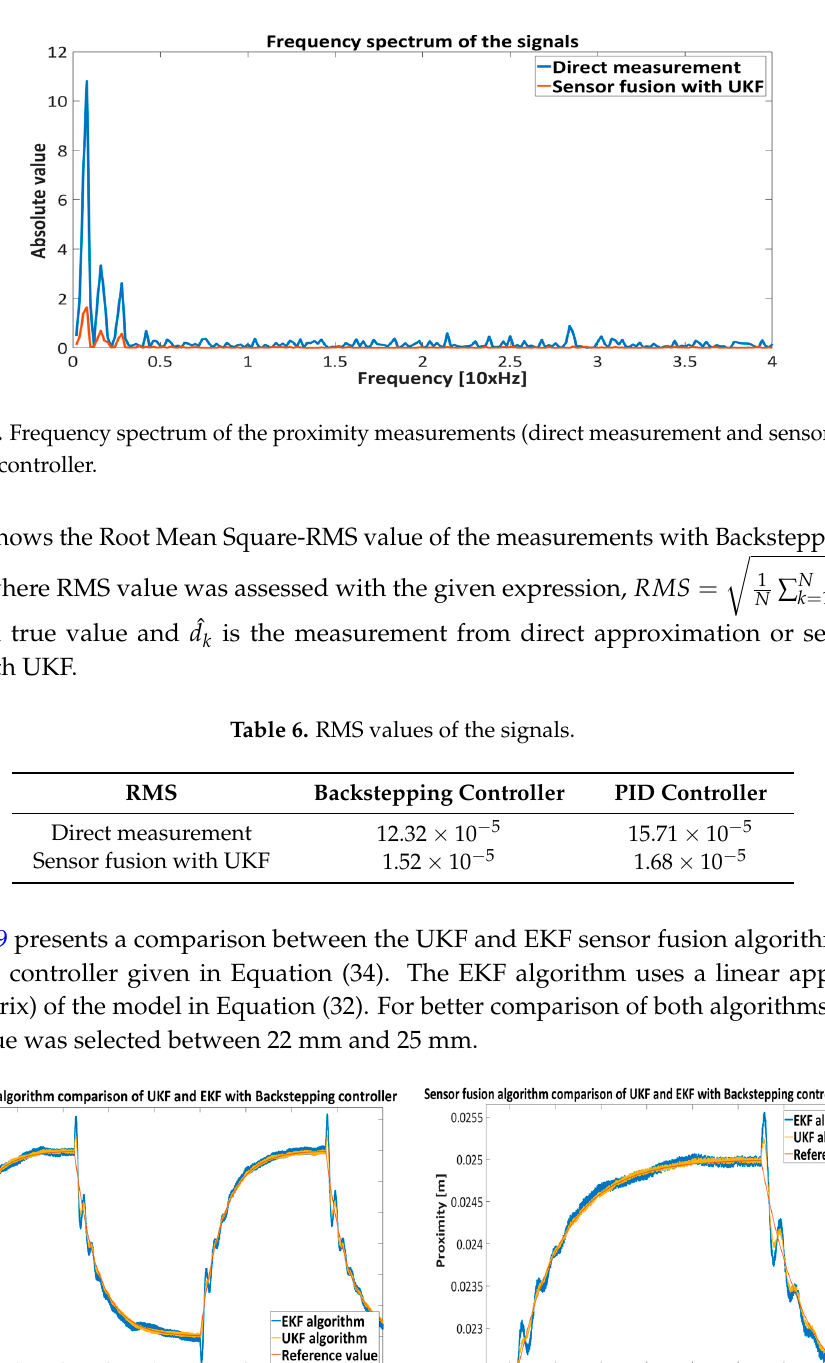
fusion) with Backstepping controller.